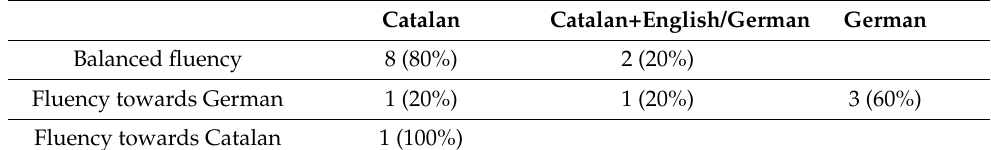
Table 7. Children’s language fluency and child’s language to the Catalan-speaking parent.